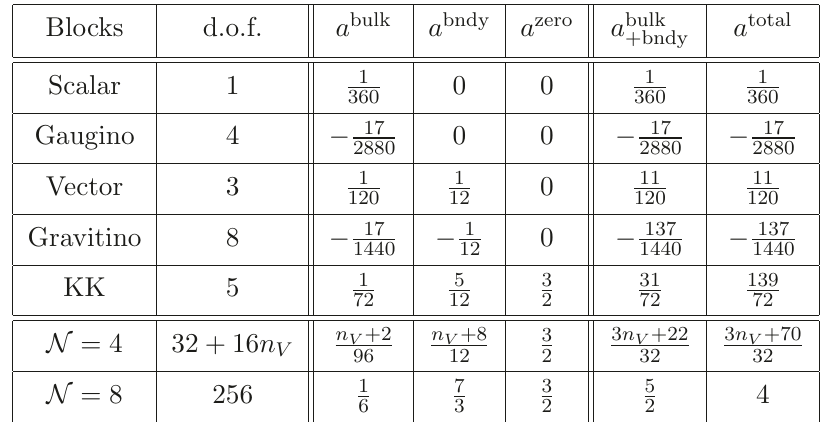
Table 4 . Anomaly Coefficients of the Non-BPS